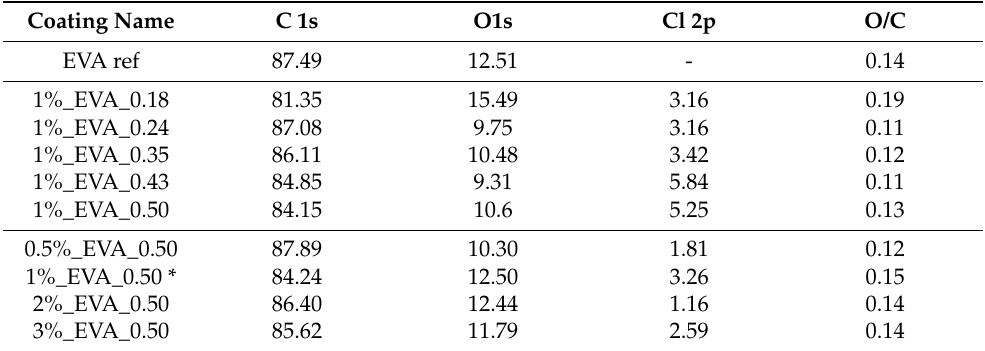
Table 2. Chemical composition of the surface estimated based on XPS survey